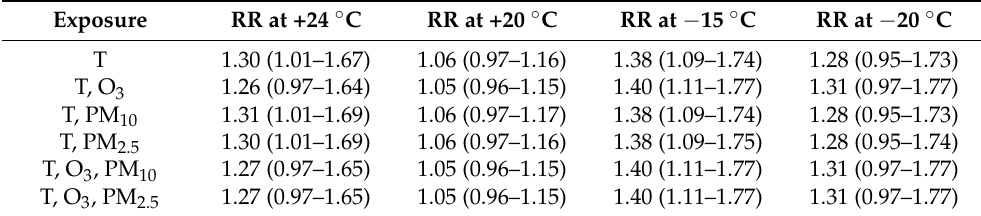
Table 3. Relative Risks (RR, 95% CI) of all-age mortality in Helsinki at various values of daily mean temperature (T) based on modelling temperature–mortality relationships with and without taking into account the air quality variables O3, PM 10 and PM 2.5